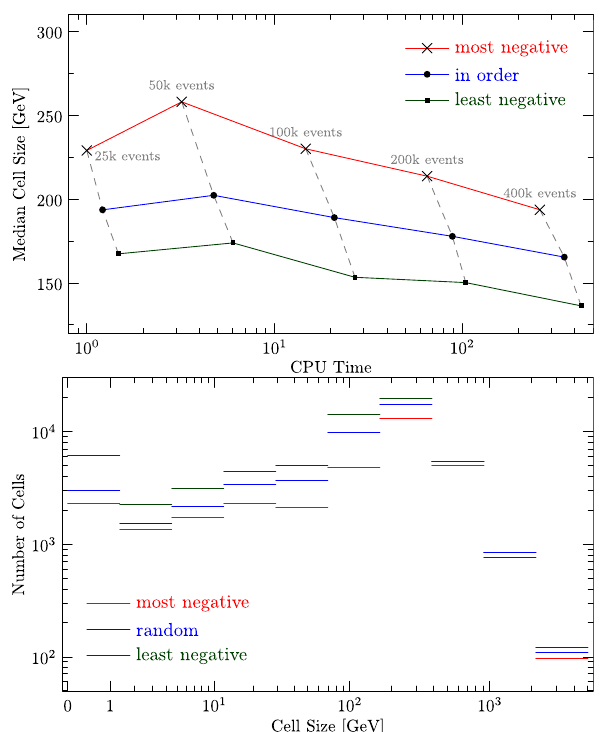
Fig. 7 Comparison of different strategies for selecting cell seeds. On the top, we show the mediancellradius as a function of computing time. Timings are normalised to the fastest run with 25 , 000 events and the “most negative” strategy. On the bottom, we show the distribution of cell radii for the sample with 400 , 000 events